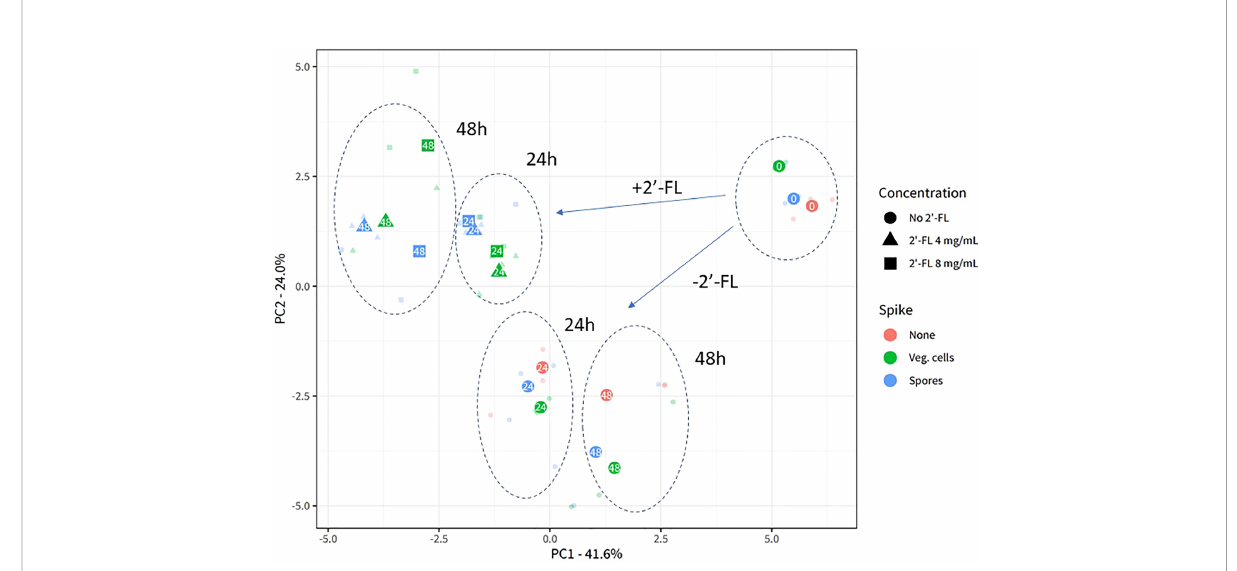
FIGURE 2 2 ’ -FL affects 16S microbial community composition in the CDi-screen. Experimental reproducibility and differentiation of microbial communities across different time points and culture conditions in the CDi-screen are shown in the principal component analysis (PCA) ordination plot with center-log ratio transformed data. The fecal microbial community was analyzed without C. dif fi cile (red) as well as with C. dif fi cile vegetative cells (green) or spores (blue), and incubated in CDi-SIEM media at pH 6.0, without (circles) and with supplementation of the media with 2 ’ -FL at doses of 4 mg/mL (triangles) and 8 mg/mL (squares), and sampled at t=0 h, 24 h, 48 h (indicated with numbers in the symbols). Only taxa that belong to the fi rst 97.5% of all sequenced counts in the data are included. All experimental data with the relevant replicate condition is shown as the centroid of the three replicates for the condition, with each sample shown in lower